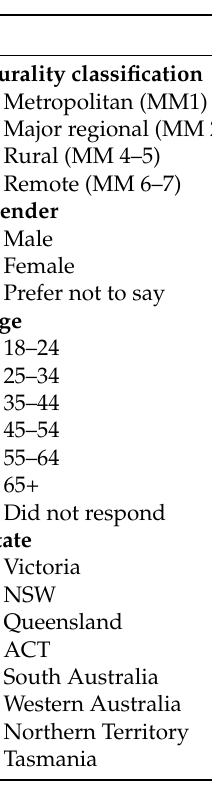
Table 2. Demographic characteristics of